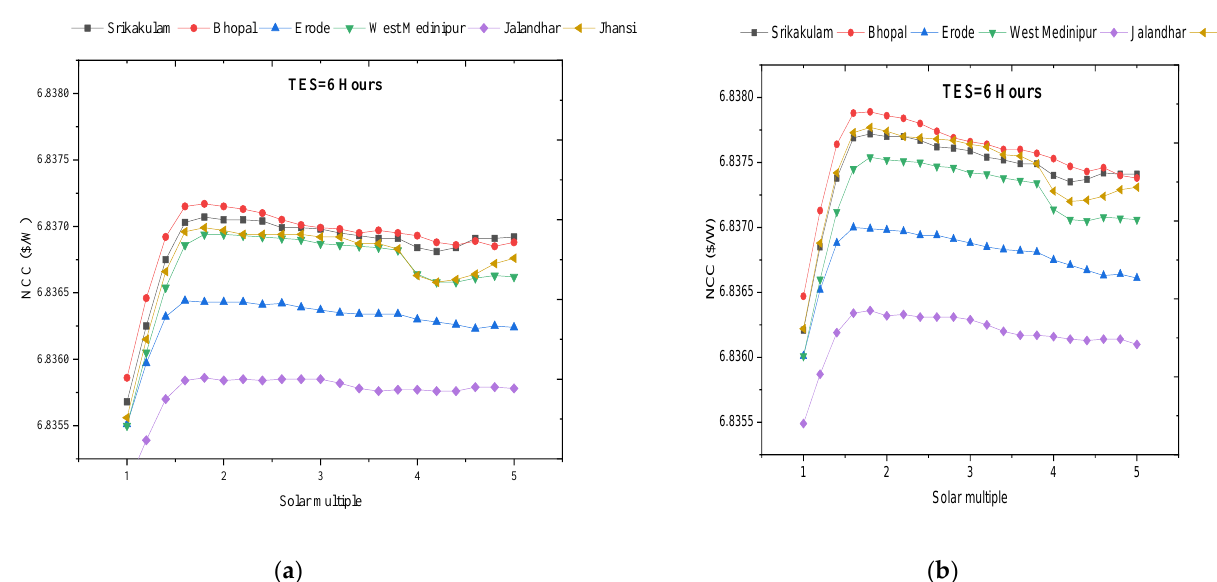
Figure 11. Effect of solar multiple on NCC on both models, ( a ) dry-cooled and ( b ) wet-cooled, at 6 h TES.